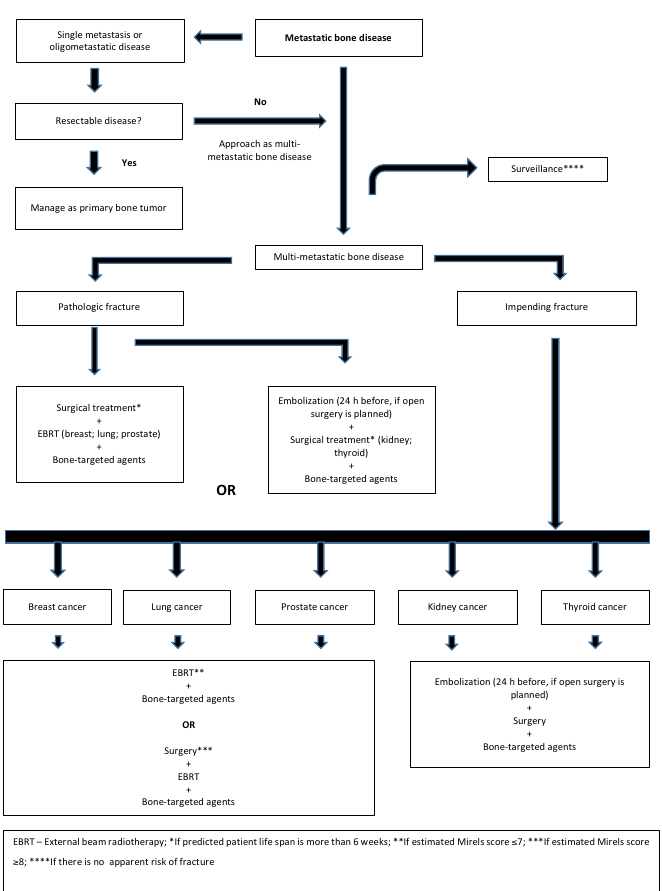
Figure 7. Decision flowchart for patients with appendicular metastatic bone